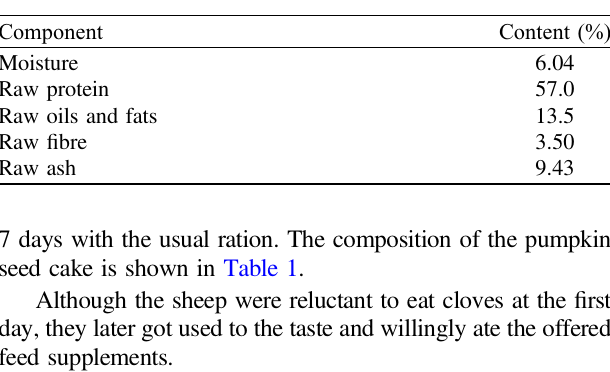
Table 1. The composition of pumpkin seed